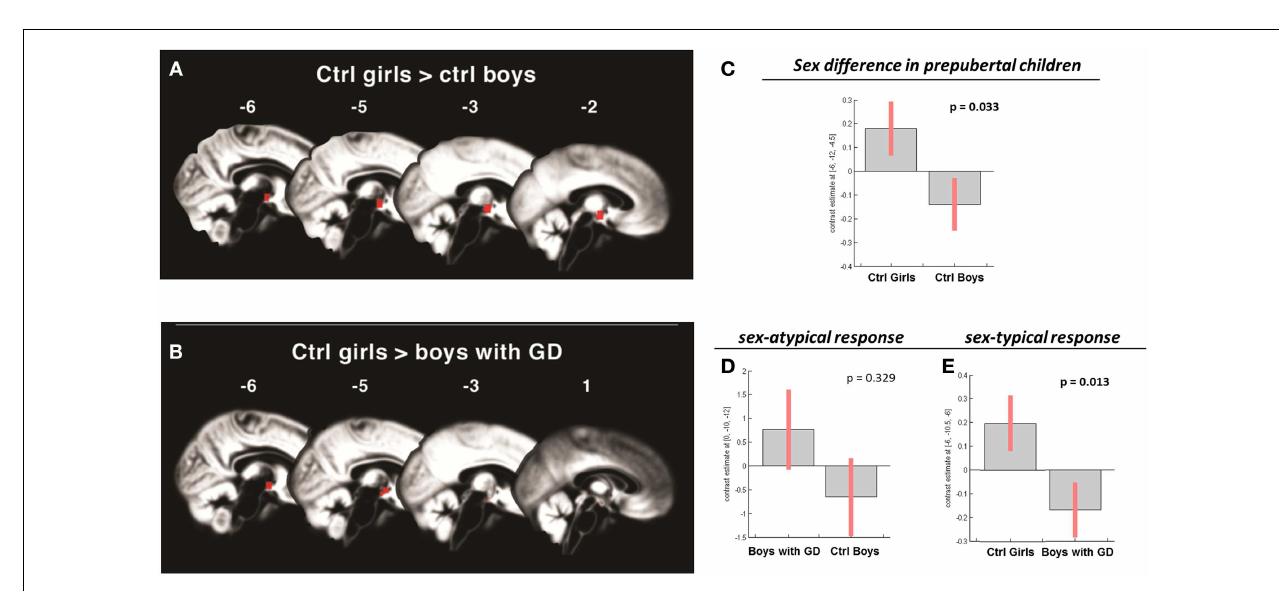
FIGURE 2 | (A,B) Show the anatomic locations of the significant hypothalamic activations, indicated in red, in response to the chemo-signal androstadienone in the pre-pubertal age groups.The numbers above each sagittal plane represent the x -axis coordinates in Montreal Neurological Institute space. All voxels within the hypothalamic region of interest, surviving the statistical threshold of p < 0.05 (FWE-corrected) are shown.